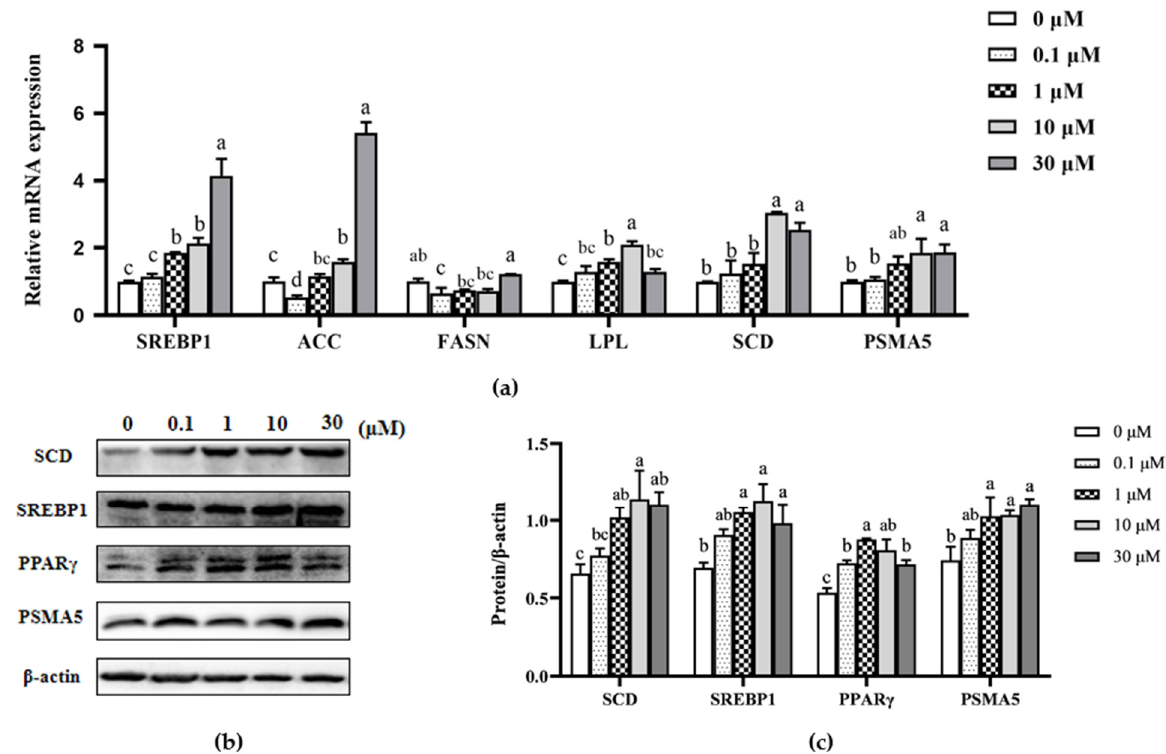
Figure 3. Effects of β -sitosterol on the expression levels of factors related to fatty acid synthesis in MAC-T cells. ( a ) mRNA expression of fatty acid synthesis-related genes determined by qPCR. ( b ) Protein levels of fatty acid synthesis-related factors detected by Western blotting. ( c ) The ratio of fatty acid synthesis-related factor proteins to β -actin control. Data are expressed as means ± SEM ( n = 3). Different lower-case letters indicate significant differences compared to the control ( p < 0.05).